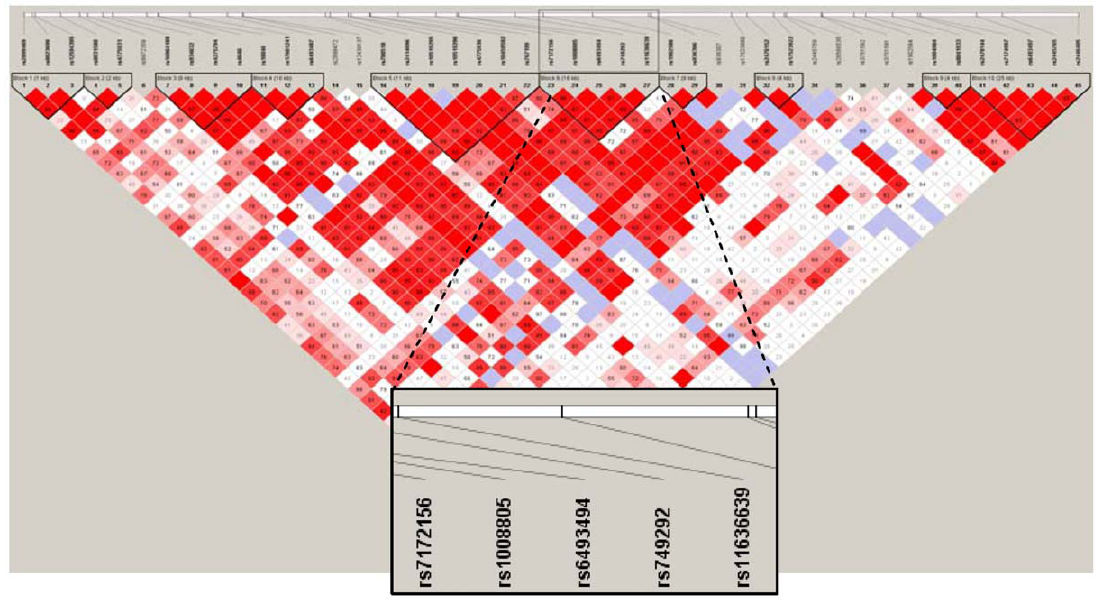
Figure 2. Linkage disequilibrium (LD) plot of the CYP19A1 gene in the Women Health Initiative Observational Study (WHI-OS) cohort. LD is based on the measures of D 9 and LOD (bright red, D 9 =1 and LOD $ 2; shades of pink/red, D 9, 1 and LOD $ 2; white, D 9, 1 and LOD , 2; blue, D 9 =1 and LOD , 2). Block # 6 (highlighted) contains the 5 SNPs with strongest associations with circulating hepatocyte growth factor (HGF)